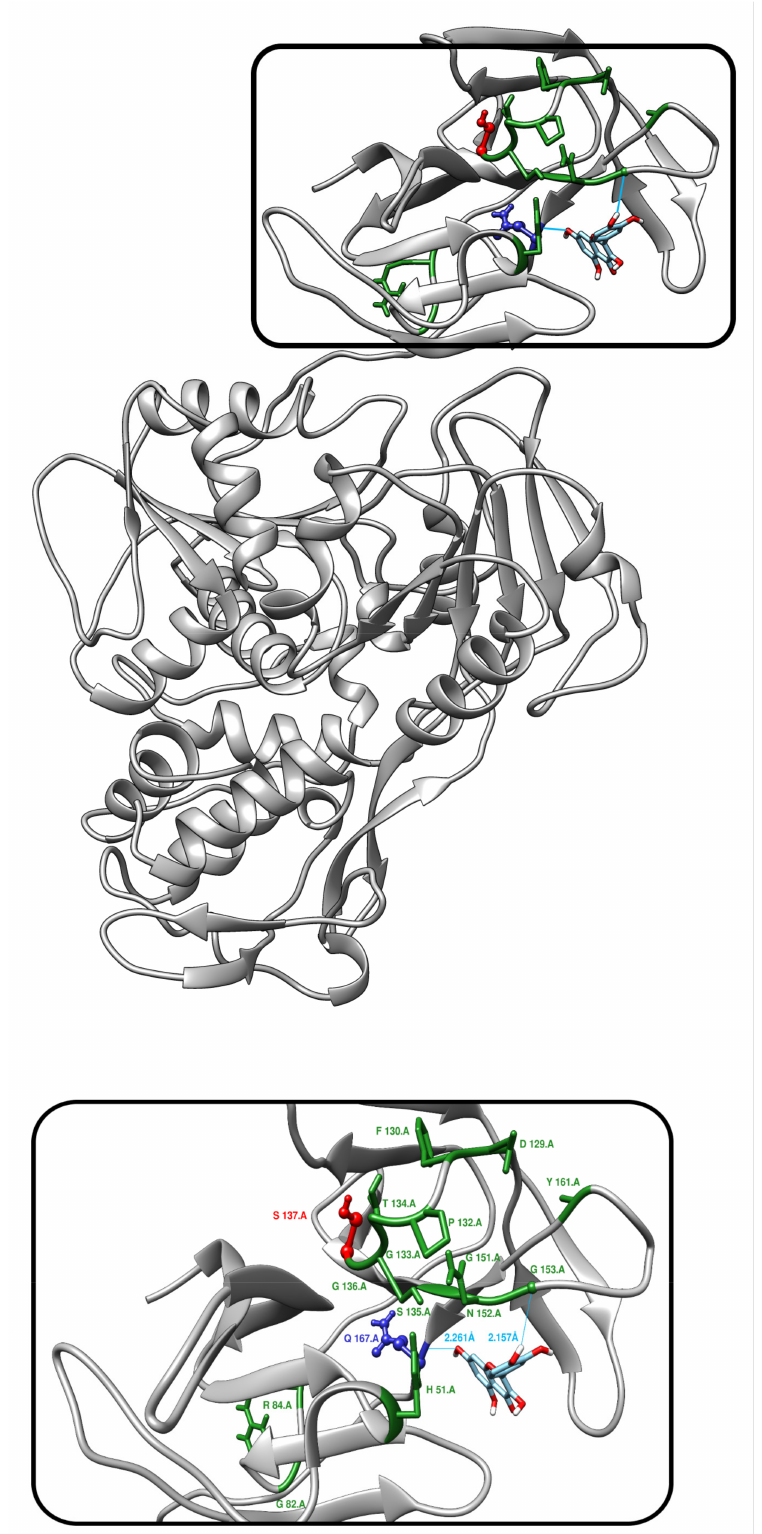
Figure 9. Docking of Quercetin with NS3. Auto-dock of Quercetin against the protease part of the Dengue virus shows that Quercetin binds very close to the S137 site occluding its access. S137 is shown red. Q167 is shown in blue and shares an H-bond with Quercetin. The catalytic triad residues are shown in green. The other H-bond is shared with